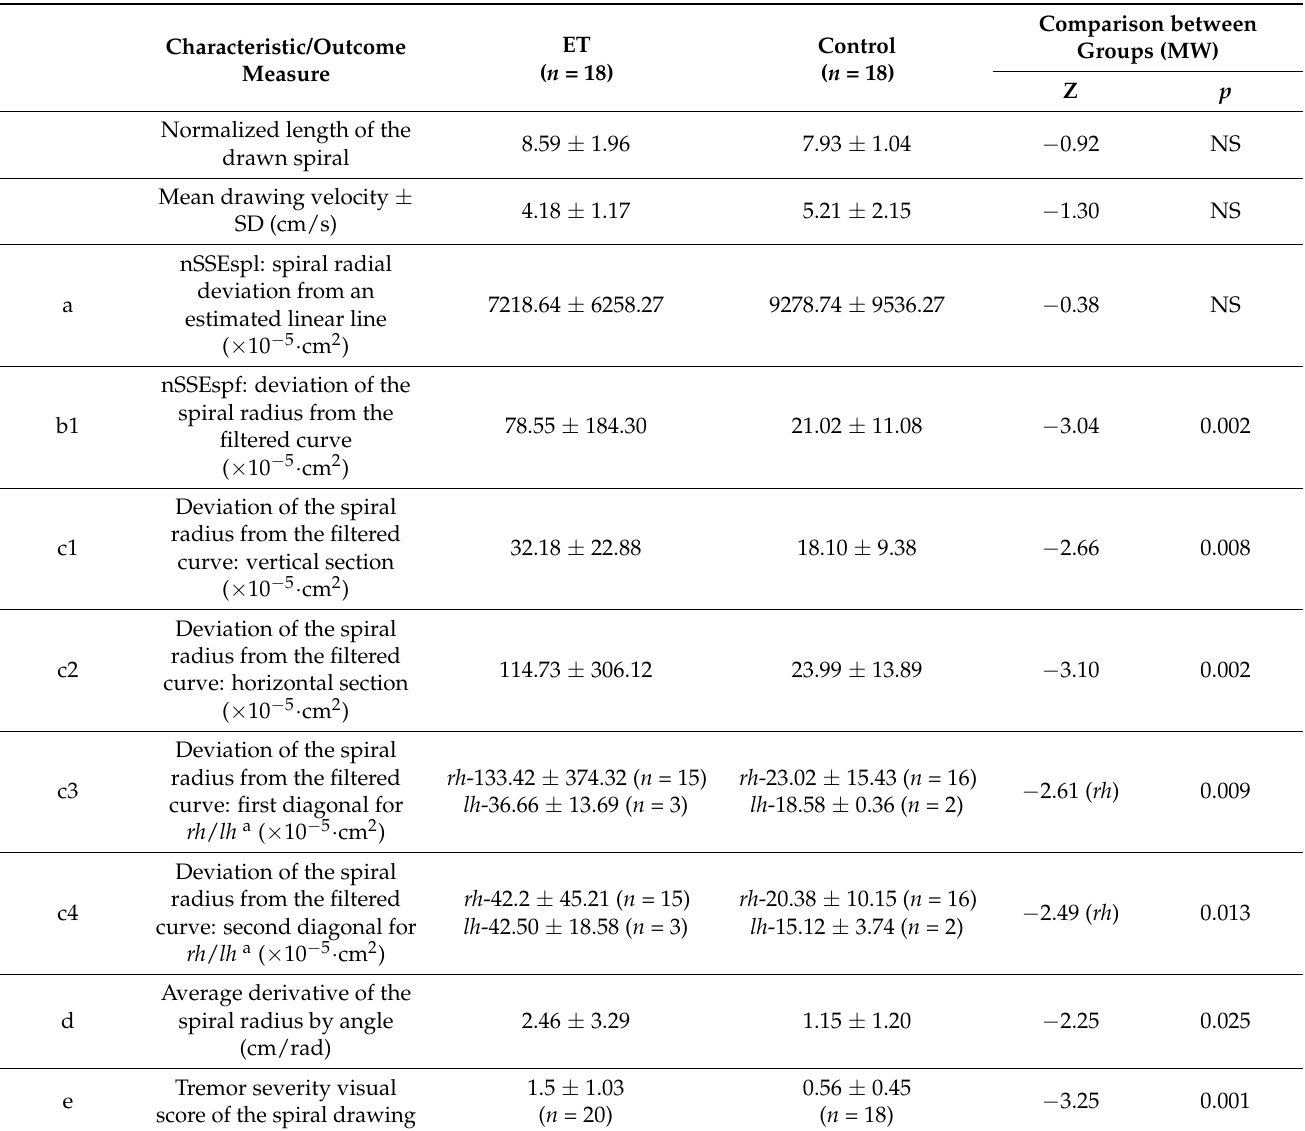
Table 2. Spiral characteristics (without first-point